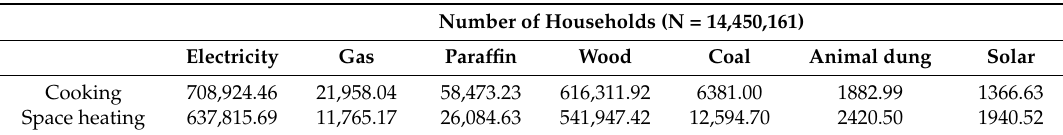
Table 1. Source of cooking and space heating fuel for population of Limpopo province. (Census,